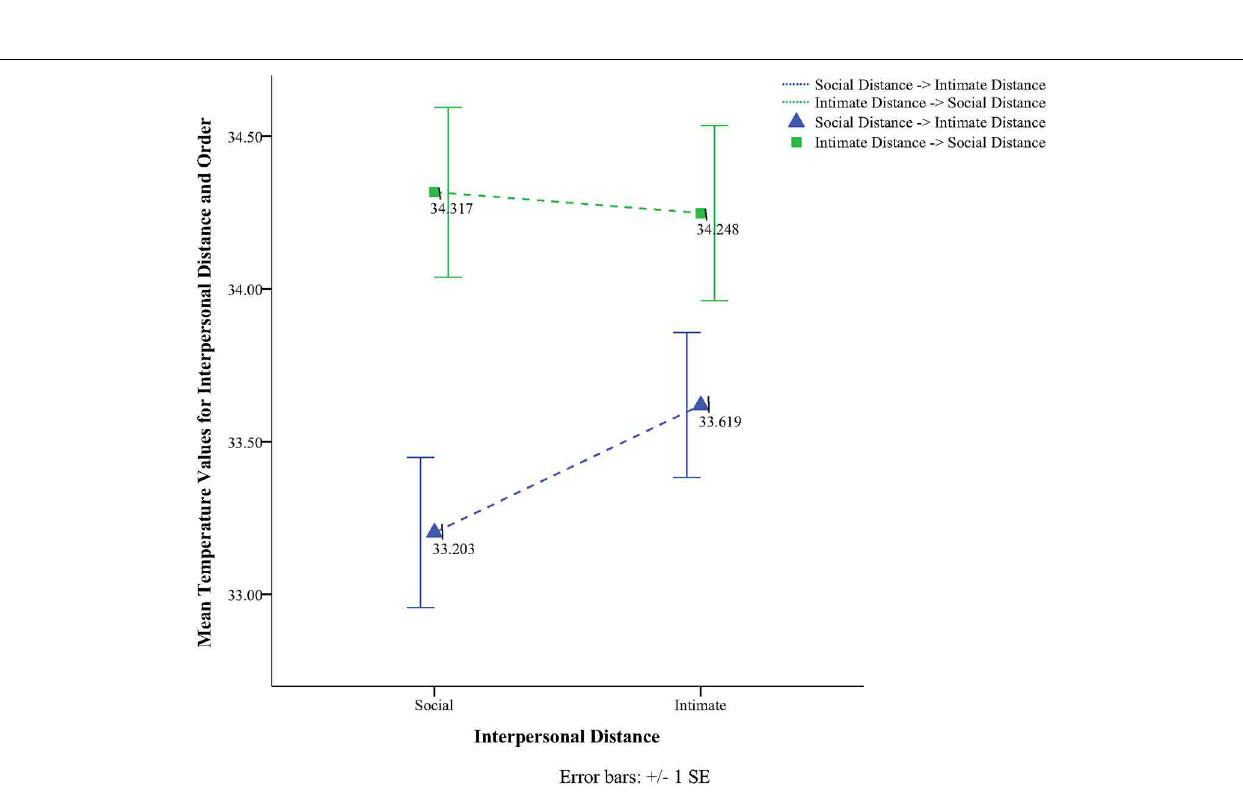
FIGURE 1 | Line graph illustrating the temperature of the face based on the experimental order of the four conditions.